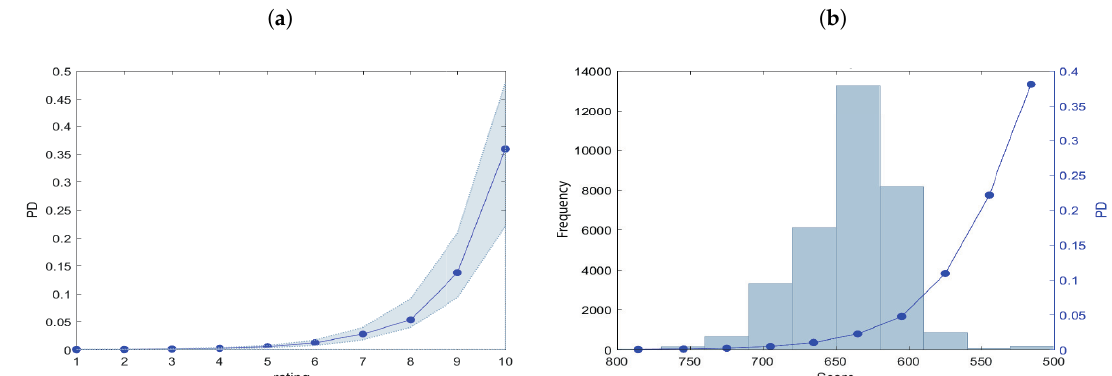
Figure 3. Panel ( a ) reports the final master scale obtained for the first pool cut-off date. To create the master scale we linearize the PD vector through the calculation of the natural logarithm, then this is divided into 10 equal classes and we convert the log of the cut-off of each class in order to identify the cut-off to be associated with each score with the exponential function. Panel ( b ) confirms the frequency of borrowers for each class. In the right y -axis we indicate the default probability associated for each class and in the left y -axis is indicated the frequency of the